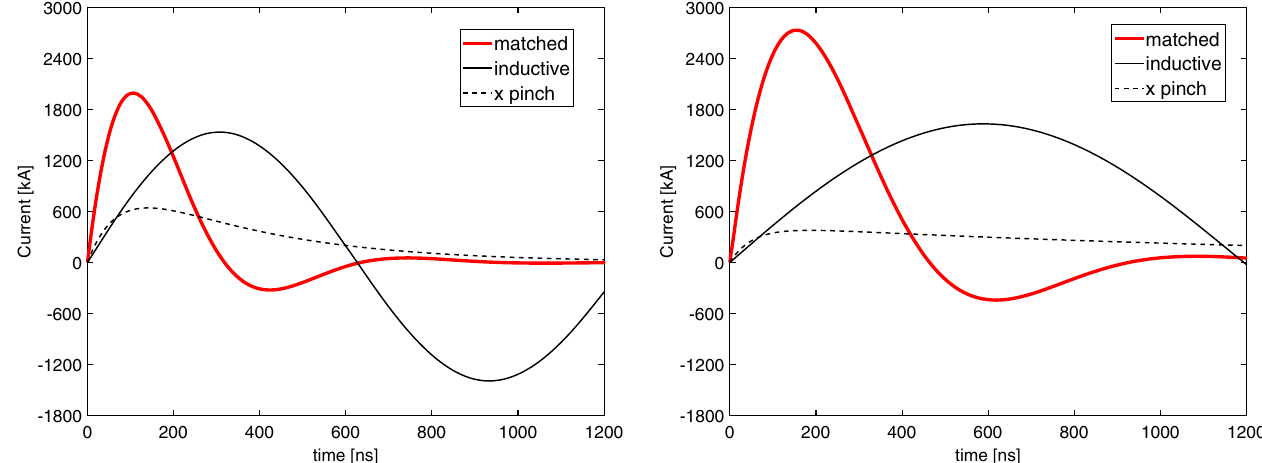
FIG. 9. Simulated output currents into matched, inductive, and x-pinch loads for a 40-brick standard pulser (left) and a 40-brick dry pulser (right). Both systems include a 0.3-nH TL.